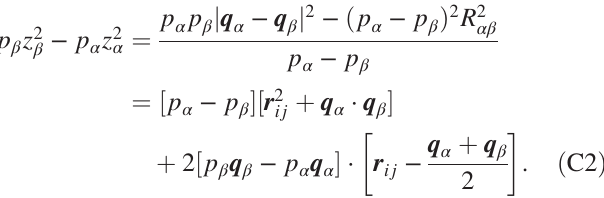
ffiffiffi p 3 = 2 (cid:2) . Using generalized Voronoi construction defined in the main text, one can easily generate arbitrary CAP networks — i.e., for any set f q α ; p α ; z α g — in mechanical equilibrium. Edges within the CAP network are defined by p d 2 p d 2 α β α ¼ β via Eq. (8). This procedure is repeated for